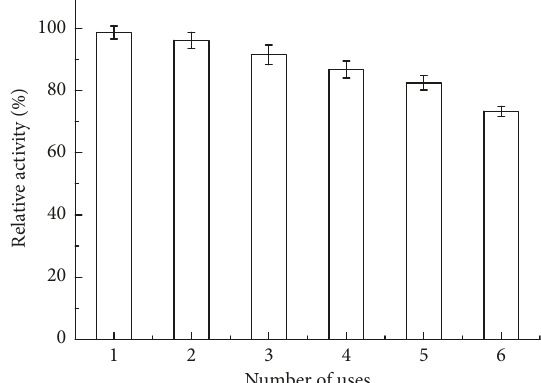
Figure 7: Reusability of PLC-Fe 3 O 4 @SiO 2 @p(GMA), using crude soybean oil as a substrate at 65 ° C with a pH of 7.5 for 2.5h. PLC- Fe 3 O 4 @SiO 2 @p(GMA) retained 82.5% relative activity after 5 re- cycles. The data were reproduced three times, and error bars in- dicate standard